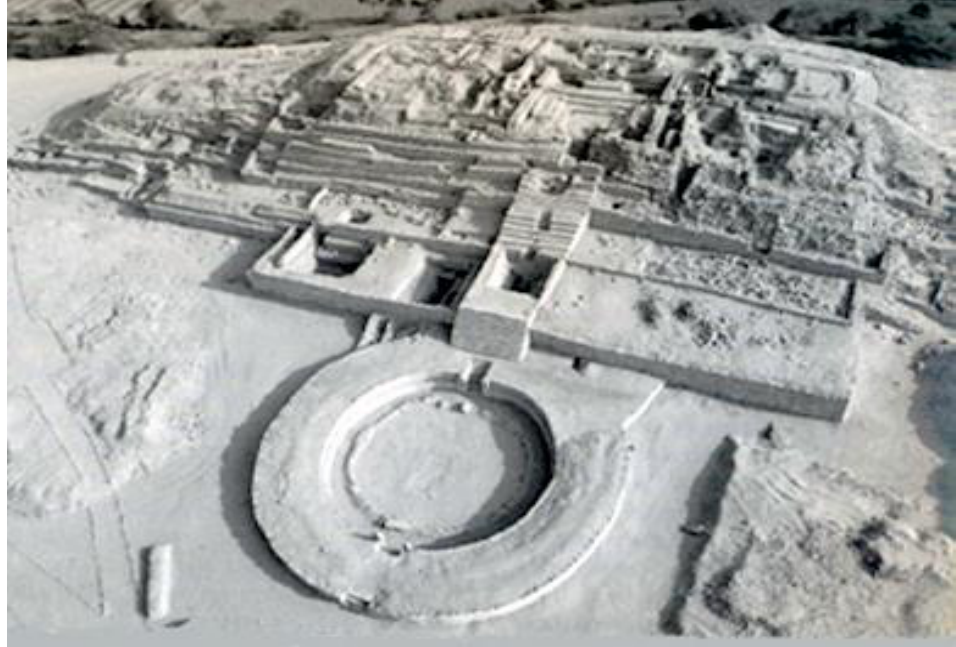
Figure 24. Details of the Major Pyramid; location indicated in Figure 23. Figure derived from [2], p. 226.